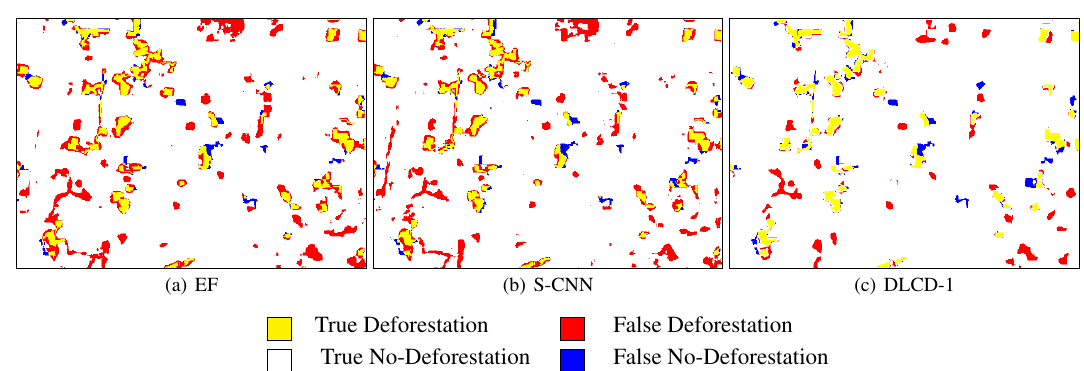
Figure 7. Test tile number 6.